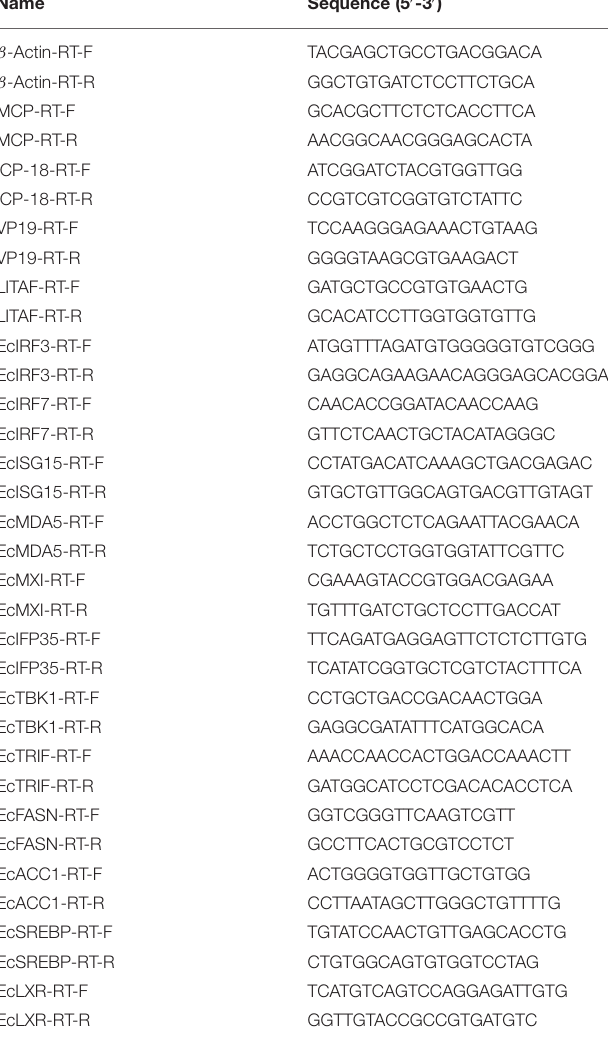
TABLE 1 | Primers used in this